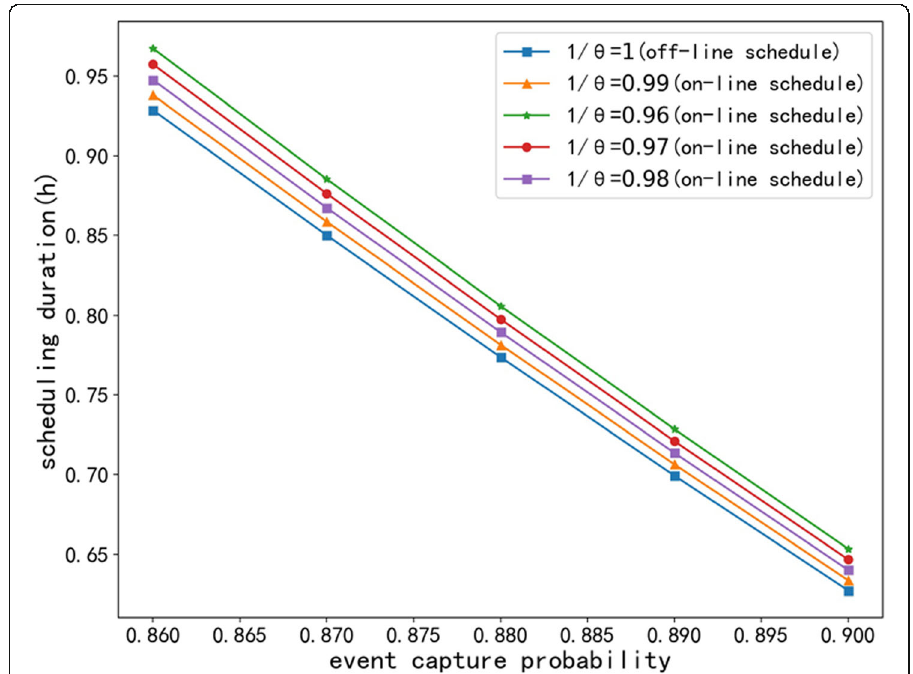
Fig. 2 Effect of event capture probability on scheduling duration in different scheduling schemes